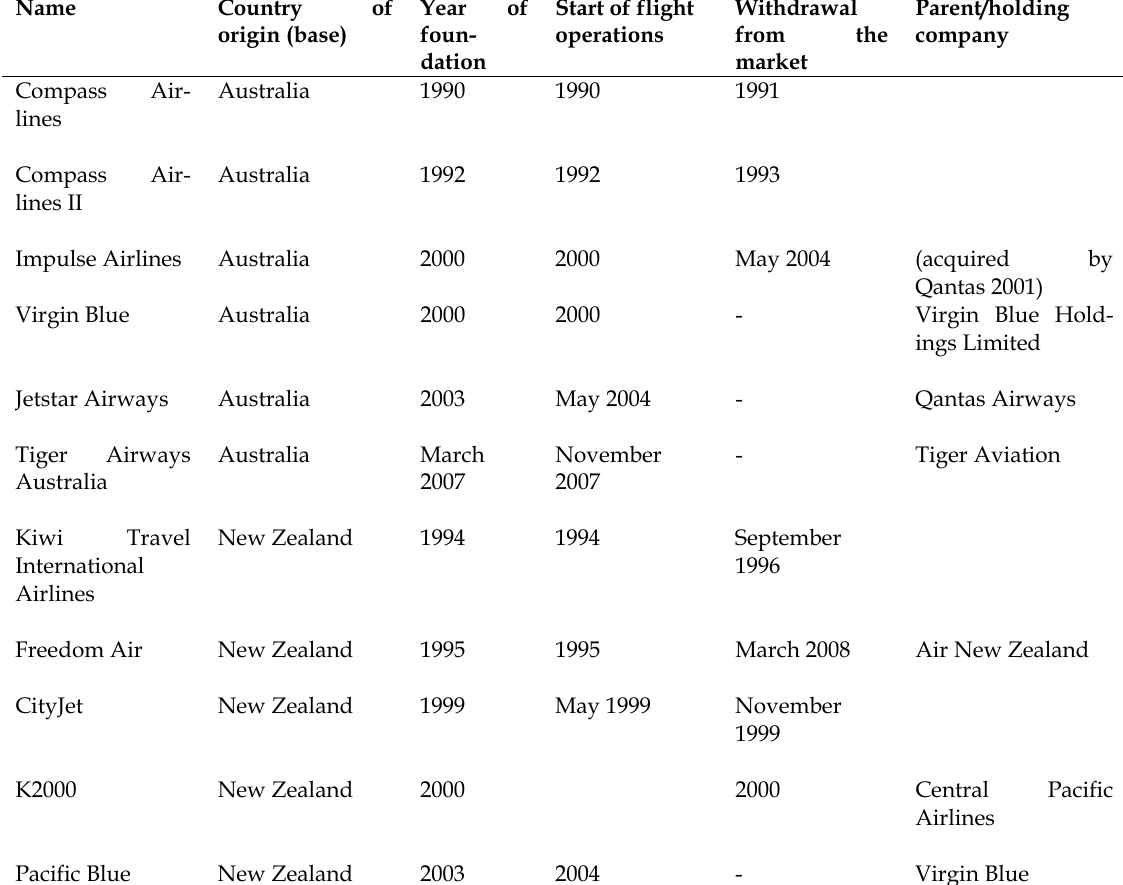
Table 3. Developments in the Australia/New Zealand low cost market